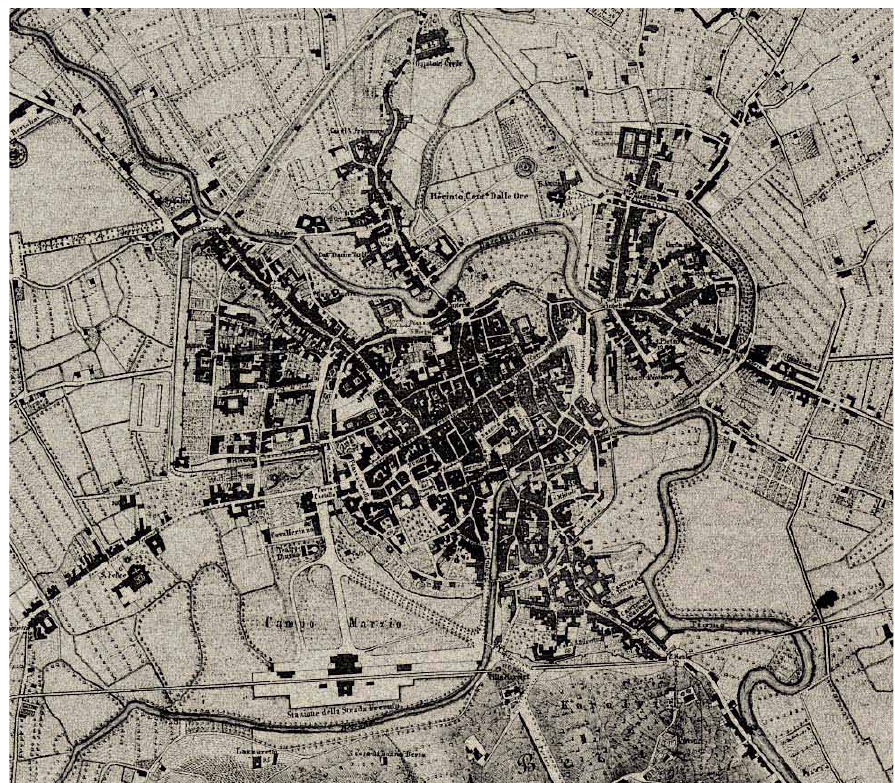
fig. 2a. Pianta della città di Vicenza ( Map of the city of Vicenza ), in a. Ciscato, Guida di Vicenza con una carta topografica della città ( Guide of Vicenza, with a topographic map of the city ), Vicenza, B. Paroni, 1870